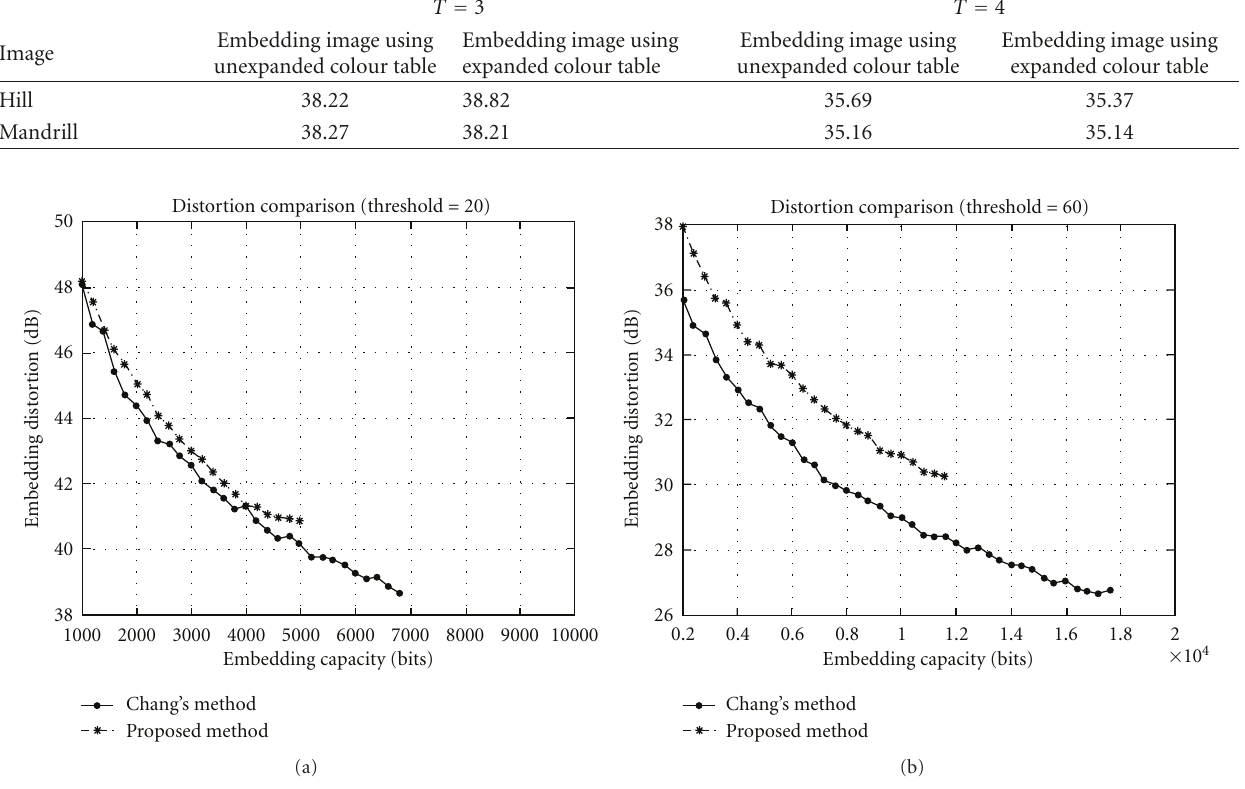
Figure 10: Distortion comparison between the PEC and CW algorithm when applied to Figure 9 with the threshold T equal to (a) 20 and (b)